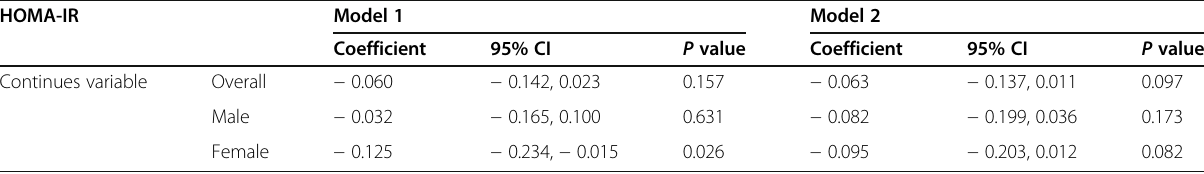
Model 1: age and gender Model 2: model 1 plus race, BMI, PIR, alcohol use, and education level Exposure variables and risk factor variables were log transformed in the